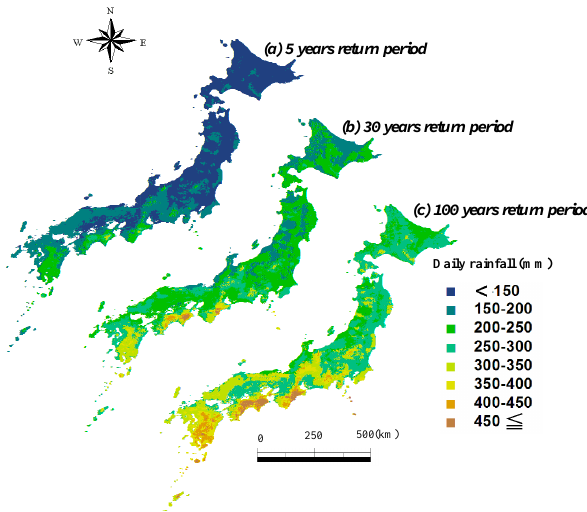
Fig. 4. Distribution of the extreme precipitation in 5 years, 30 years Figure 4. Distribution of the extreme precipitation in 5 years, 30 years and 100 years and 100 years return return periods